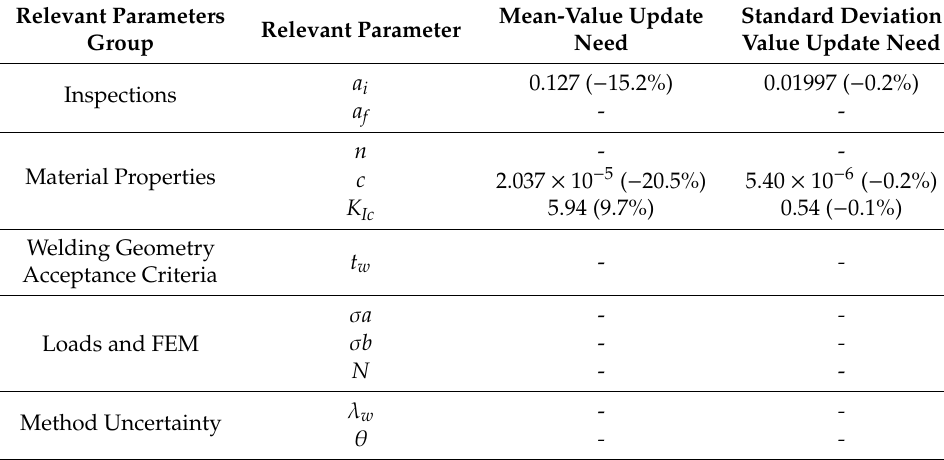
Table 9. AM-Case parameters update